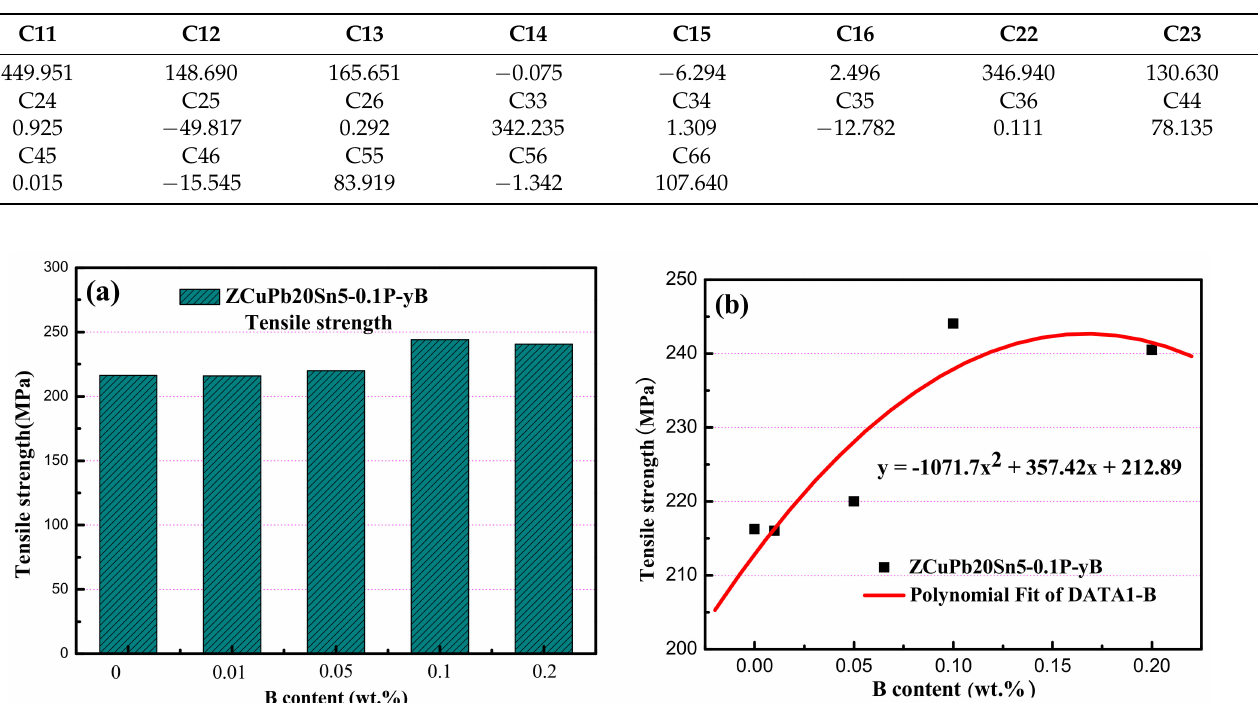
Figure 12. Tensile strength of ZCuPb20Sn5 alloy with different element contents. ( a ) tensile strength ofZCuPb20Sn5-0.1P-yB; ( b ) Fitting